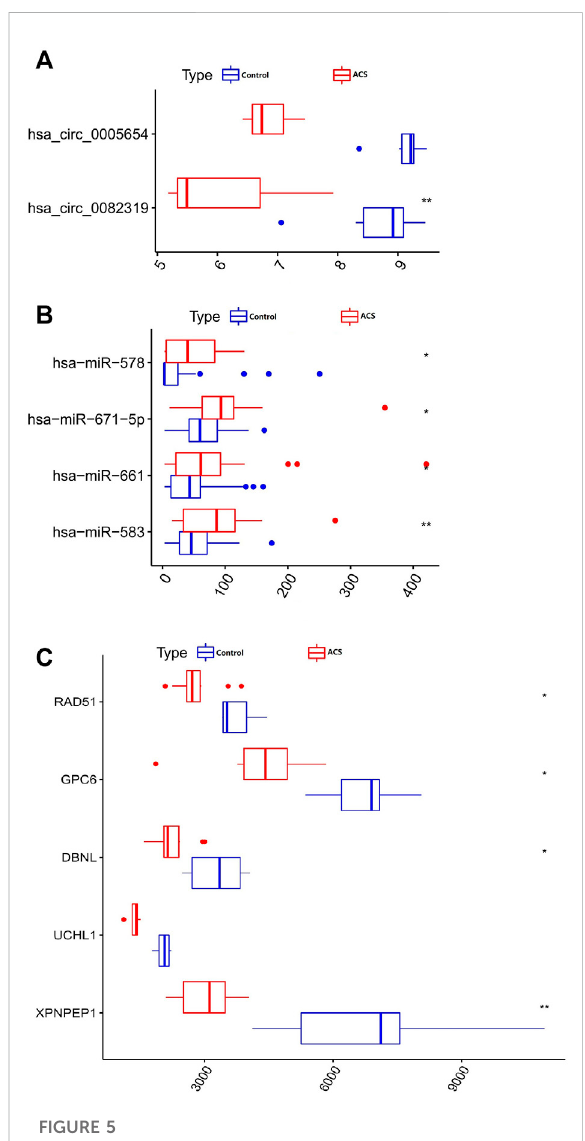
FIGURE 5 Boxplot of circRNA, miRNA, and mRNA in the